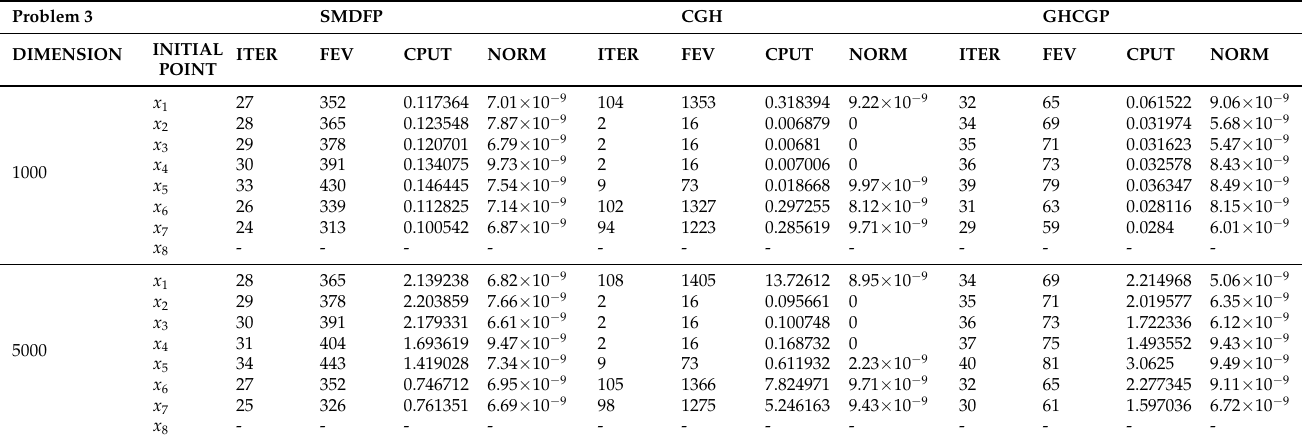
Table 3. Numerical comparison of the SMDFP, CGH [61], and GHCGP [62]